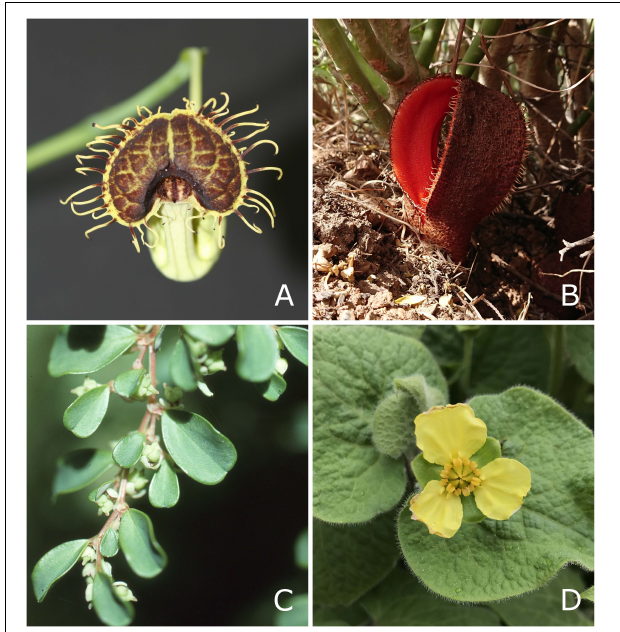
FIGURE 1 | Representatives of perianth-bearing Piperales. (A) Flower of Aristolochia fimbriata (Aristolochiaceae), (B) flower of Hydnora africana (Hydnoraceae), (C) Lactoris fernandeziana with fruits (Lactoridaceae, provided by Tod Stuessy), and (D) flower of Saruma henryi (Asaraceae, provided by Christoph